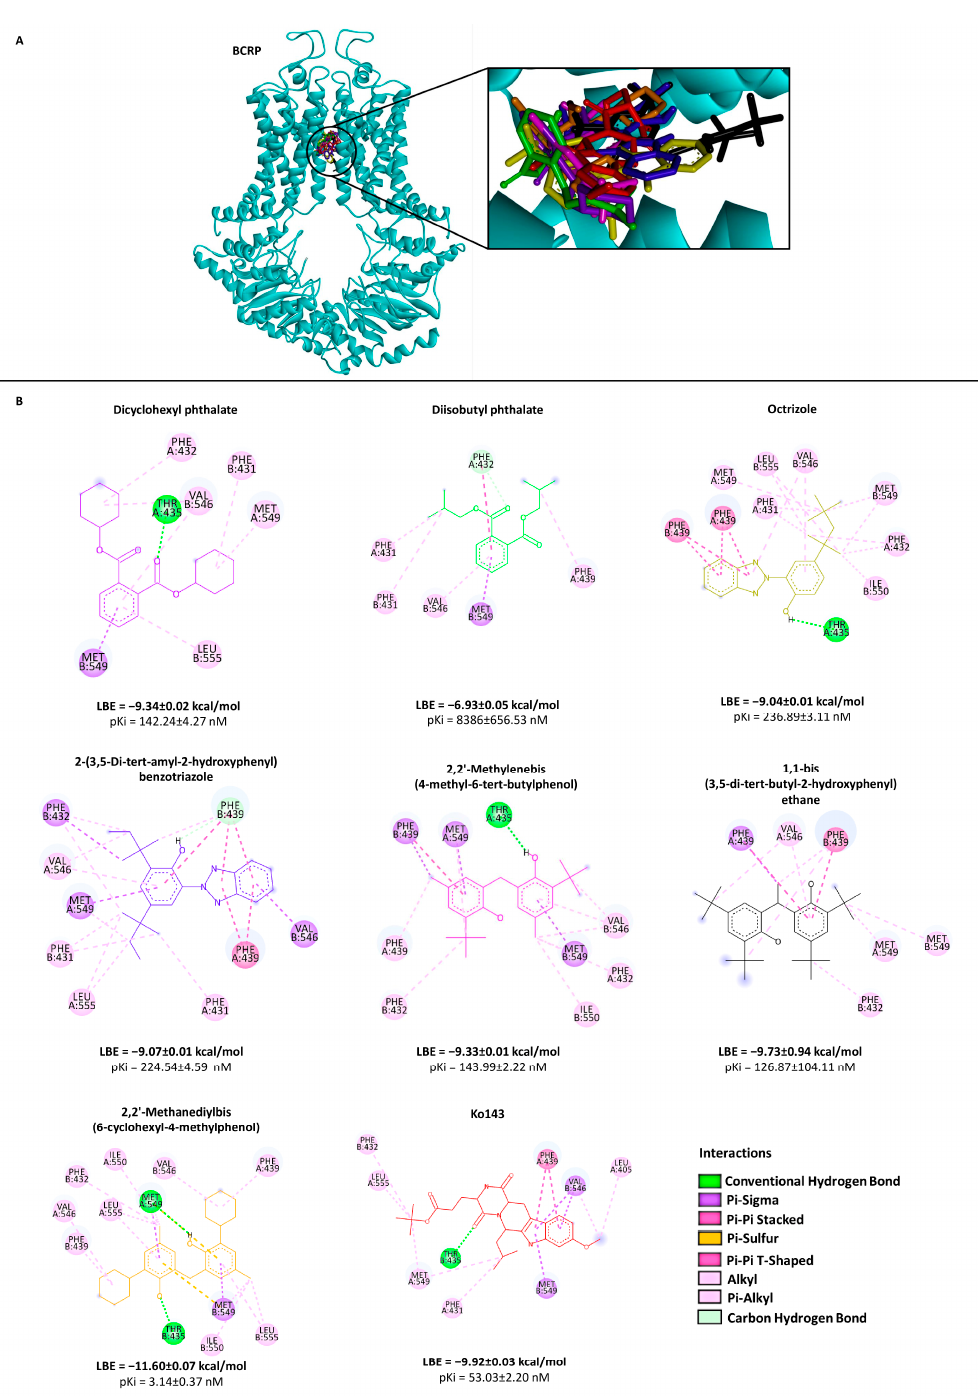
Figure 3. Representation of the binding mode between seven selected compounds and BCRP. ( A ) Three-dimensional structure of a BCRP model (cyan) and the lowest-energy conformation of the selected compounds and the positive control Ko143 docked onto the BCRP drug-binding pocket. ( B ) Two-dimensional representation of the different types of interactions formed between the pre- dicted interactive amino acids of BCRP and the respective selected compounds as visualized by Discovery Studio Visualizer software. The lowest binding energies (LBE) as well as the predicted inhibition constant (pKi) values for each compound with BCRP are shown based on the molecular docking results obtained from AutoDockTools. Ko143 was used as a positive control. Chemical structures are displayed according to the color code in panel ( A ).